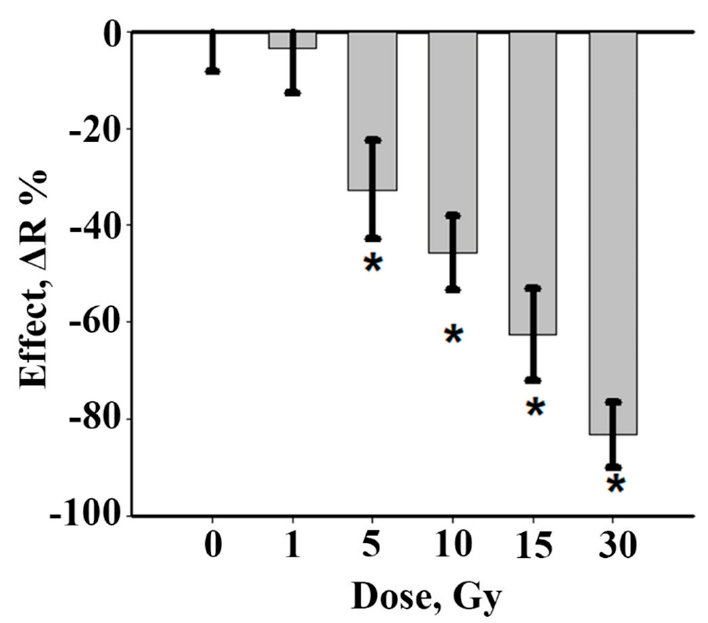
Figure 1. Inhibition of planarian head blastema growth on the 3rd day after X-ray irradiation (1— ± standard error, n = 90, * p < 30 Gy). Data are shown as mean values ± standard error, n = 90, * p < 0.001. (1–30 Gy). Data are shown as mean values